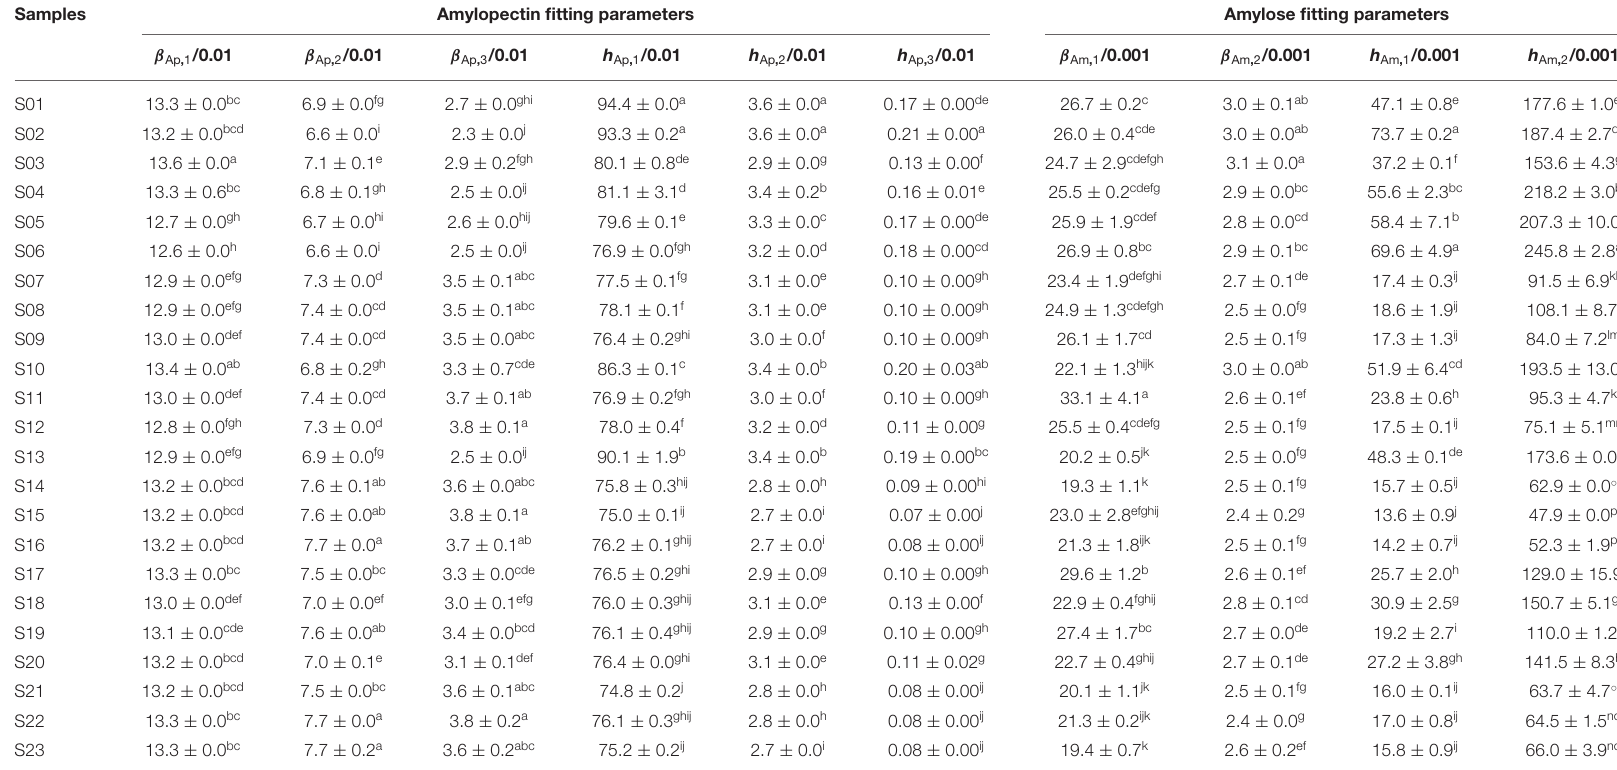
Mean ± standard deviation is calculated from duplicate measurements; values with different letters in the same column are significantly different at p <